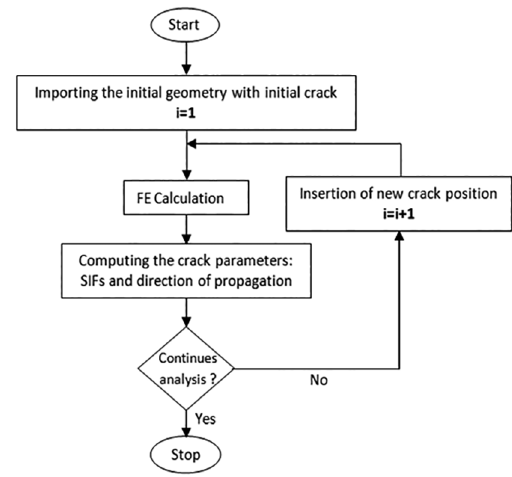
Figure 4: A flowchart of the main operations which make the crack propagation